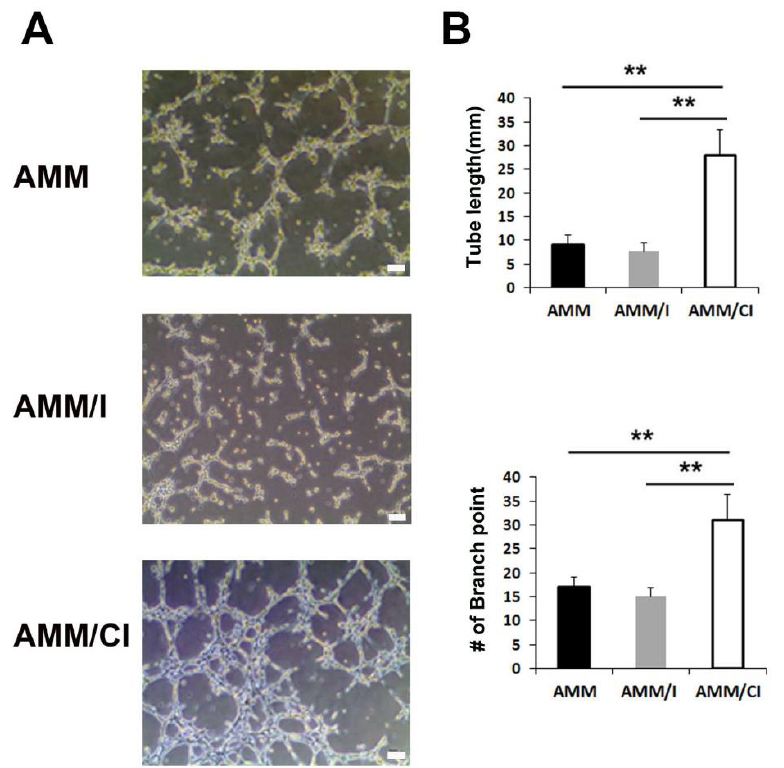
Figure 2. Matrigel tube formation of secreted factors derived from AMM/CI. ( A ) Representative pictures of Matrigel tube formation induced by CM of AMM, AMM/I, or AMM/CI for 3 h. Bars: 200 μ m. ( B ) Quantification of Matrigel tube formation. Numbers of tube lengths and branching points were significantly higher in CM of AMM/CI compared with AMM or AMM/I. ** p < 0.01, n = 5 per group.